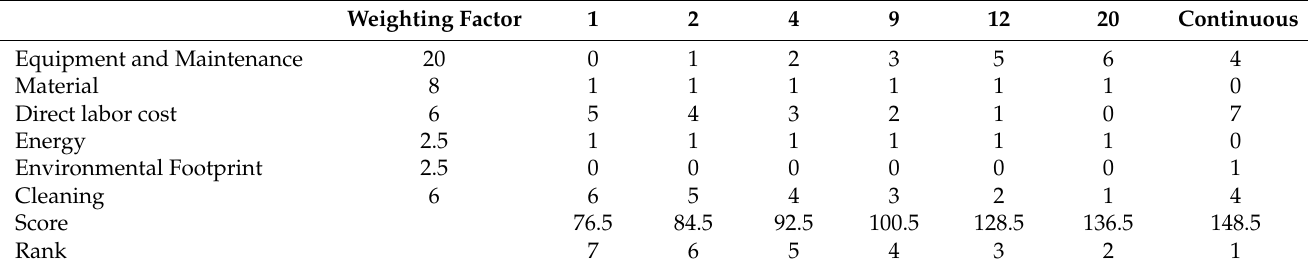
Table 2. Performance indicators of different fed-batch scenarios vs. a 3-stage continuous